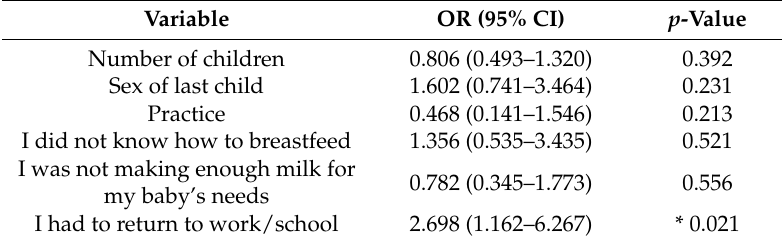
Table 5. Association between significant predictors and